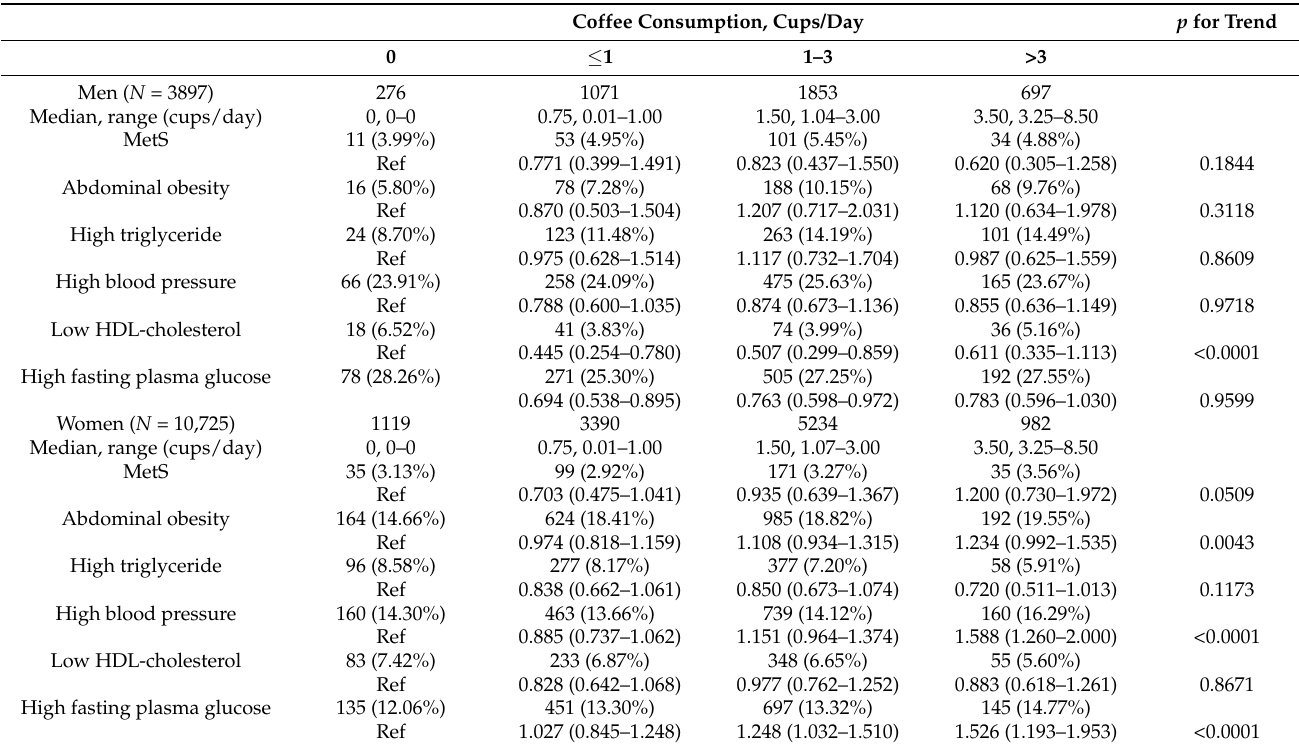
Table 2. The association between total coffee consumption and the incidence of MetS and its five components (reference group: non–coffee consumers) 1 .